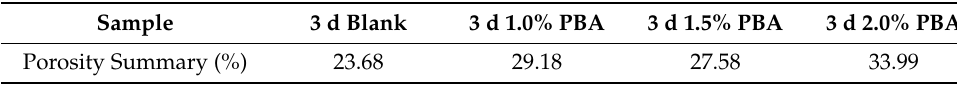
Figure 9. Pore structure of samples with different PBA content for 7 days: ( a ) pore size distribution and ( b ) cumulative porosity. Table 6. Total porosity of cement sample at 3 days.